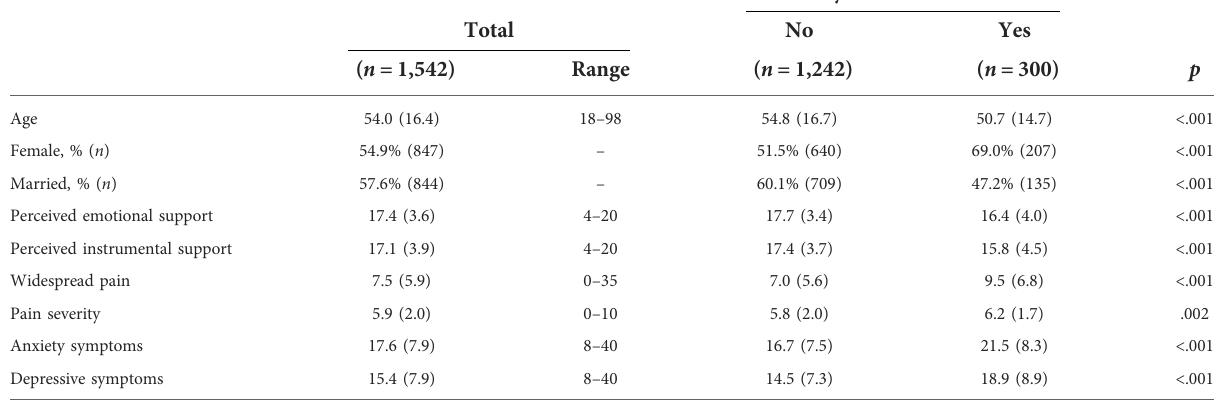
TABLE 1 Descriptive statistics and group differences by history of childhood